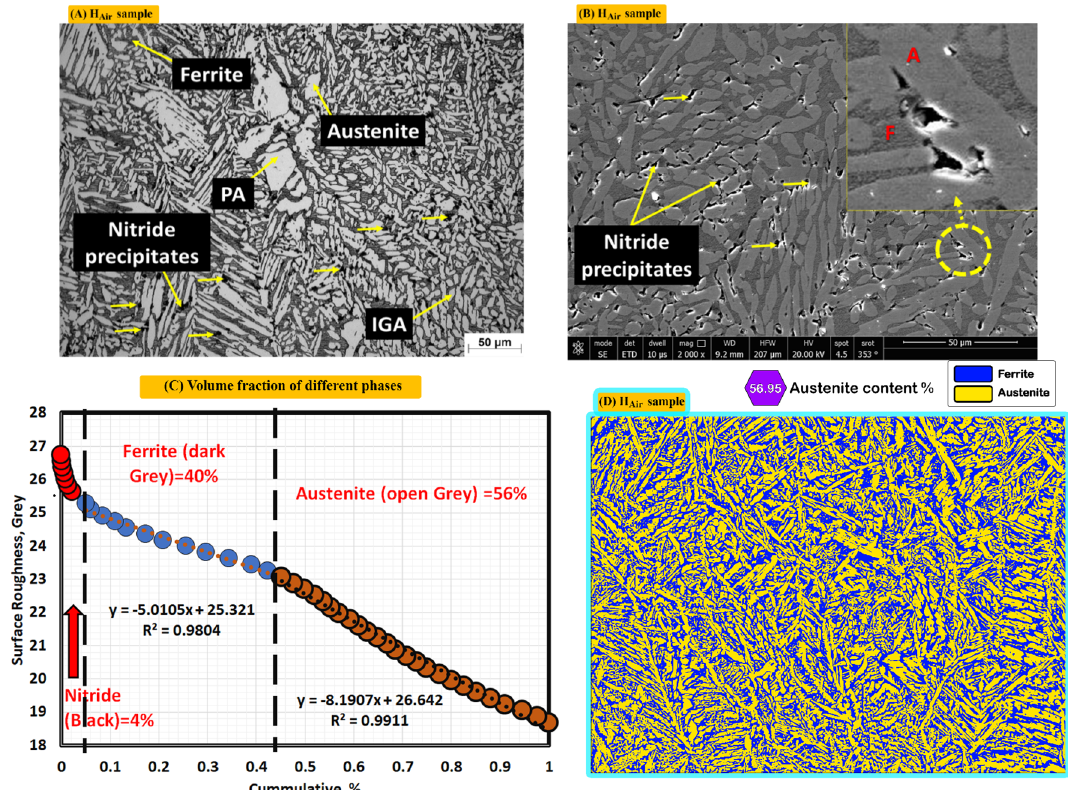
Figure 7. Optical, SEM micrographs and different volume fractions for weld zones of sample (H Air ) not protected during PWHT process ( A ) optical microstructure, ( B ) SEM photo, ( C ) volume fraction by MATLAB software, and ( D ) austenite content of one random image of weld zone by image J